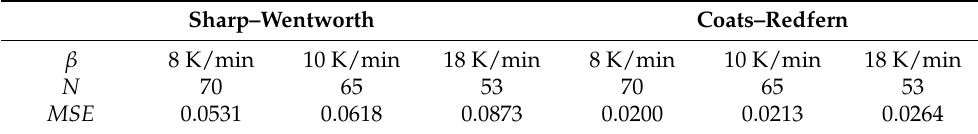
Table 7. The mean square errors of the reaction of Fe 2 O 3 → Fe 3 O 4 for Taylor expansion.